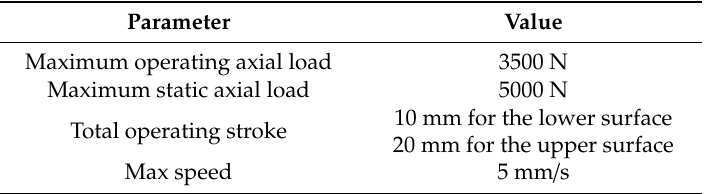
Table 1. Actuators’ performance Table 1. Actuators ’ performance requirements.